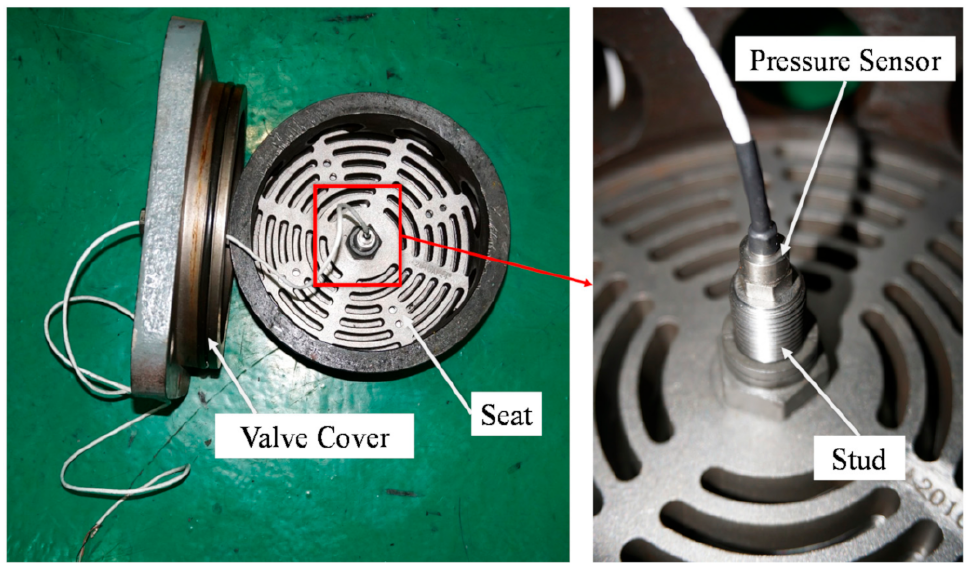
Figure 6. Arrangement of the pressure sensor.